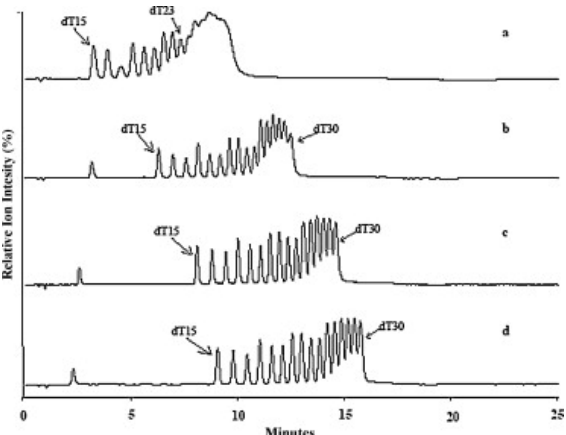
Figure 7. Separation of oligonucleotides dT15-30. PEEK ZIC ® – HILIC, 100 mm × 2.1 mm, 3.5 µm column. Mobile phase A: Milli-Q H 2 O; B: acetonitrile; C: 100 mM ammonium acetate, pH 5.8. Gradient from 70% to 60% B in 15 min, with constant C 5% ( a ), 10% ( b ), 15% ( c ) and 20% ( d ), flow rate, 0.6 mL/min but only 0.2 mL/min split to MS, temperature, 50 °C; 10 picomole each injected (reprinted from Ref. [93], copyright 2021 with permission from Elsevier, license number